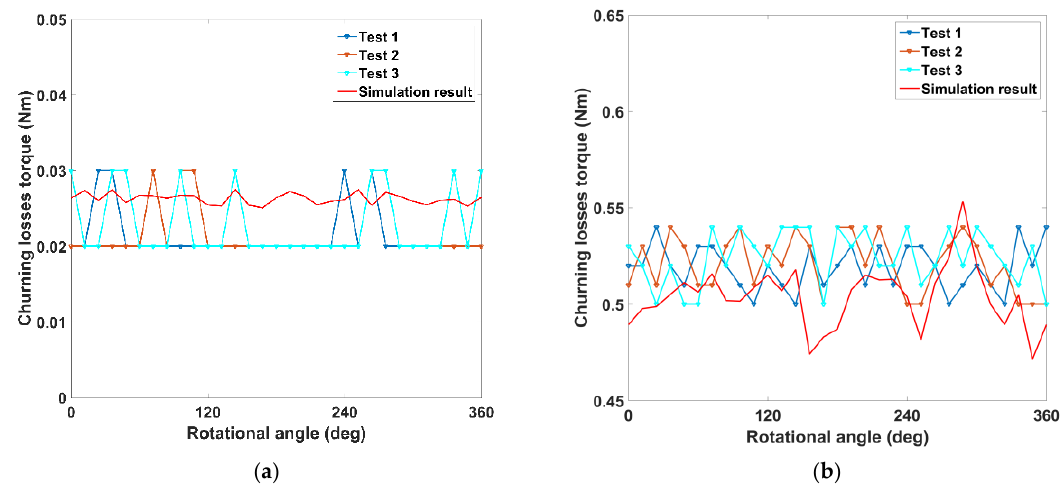
Figure 14. The torque distributions of the churning losses with different rotational angles: ( a ) at a rotational speed of 1000 rpm; ( b ) at a rotational speed of 8000 rpm.